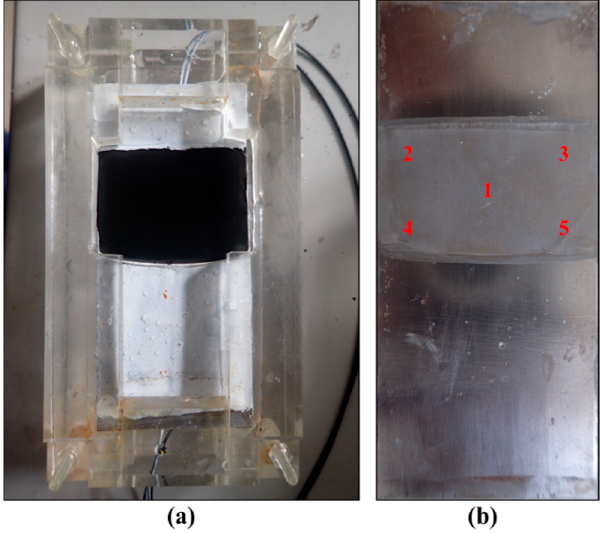
Table 2. Comparison of thickness reduction measured by thickness and weight loss.